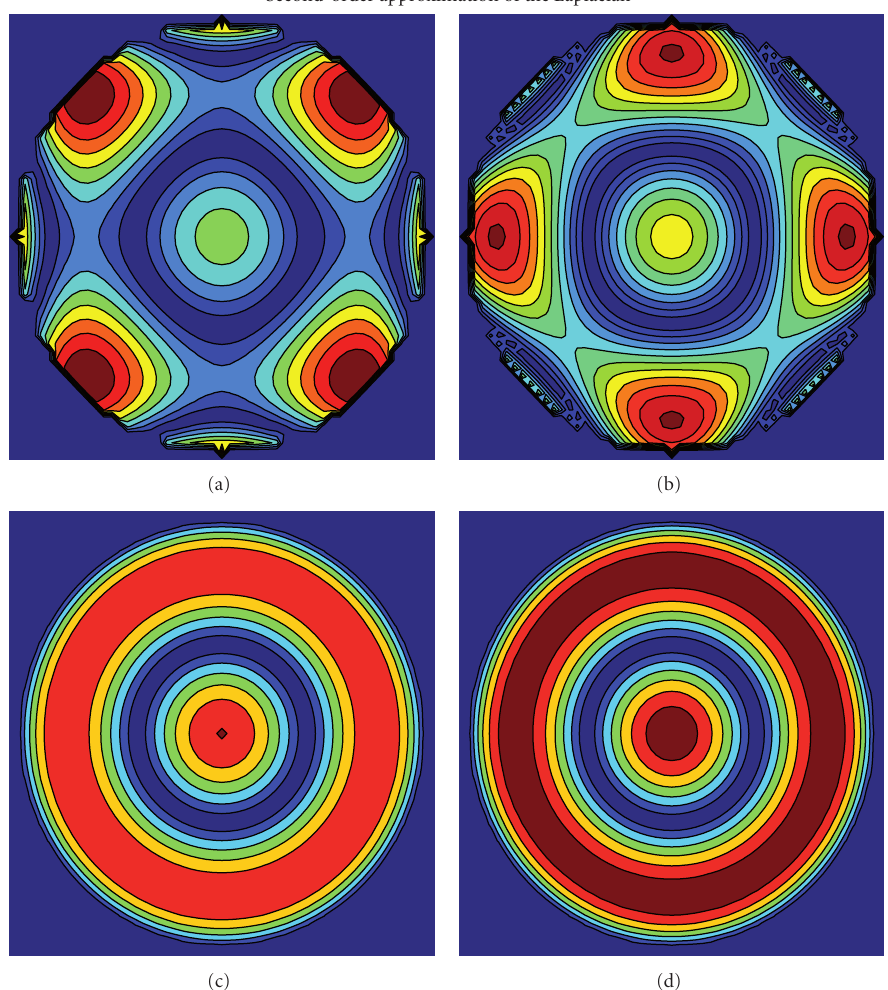
Figure 3: Isocontours of the local relative errors when numerical solutions of the diffusion equation are computed using second-order accurate finite-difference approximations for the Laplacian. The errors are anisotropic for two of the approximations, (a) the standard five- point stencil and (b) (41) with D2Q9, while for the remaining two, (c) the Mehrstellen approximation and (d) (41) with D2V17, the errors are isotropic. The numerical results conform with the theoretical predictions. The colors are not scaled between the